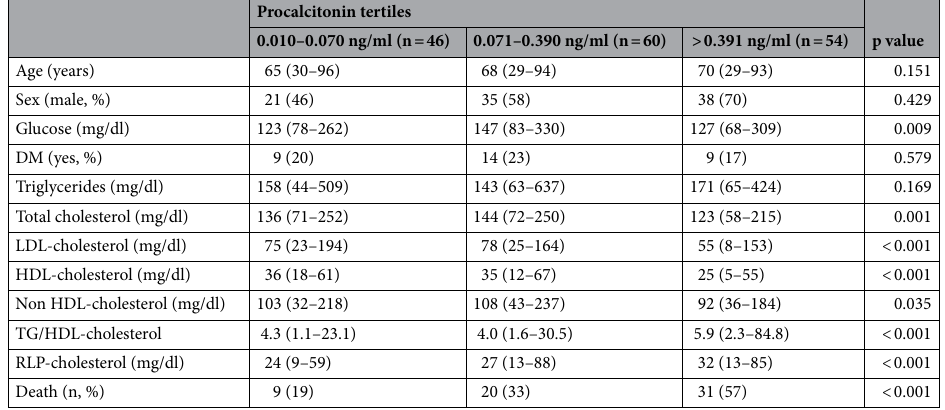
Table 3. Clinical and biochemical characteristics of COVID-19 patients according to procalcitonin tertiles. DM diabetes mellitus. Chi square test. Kruskal Wallis